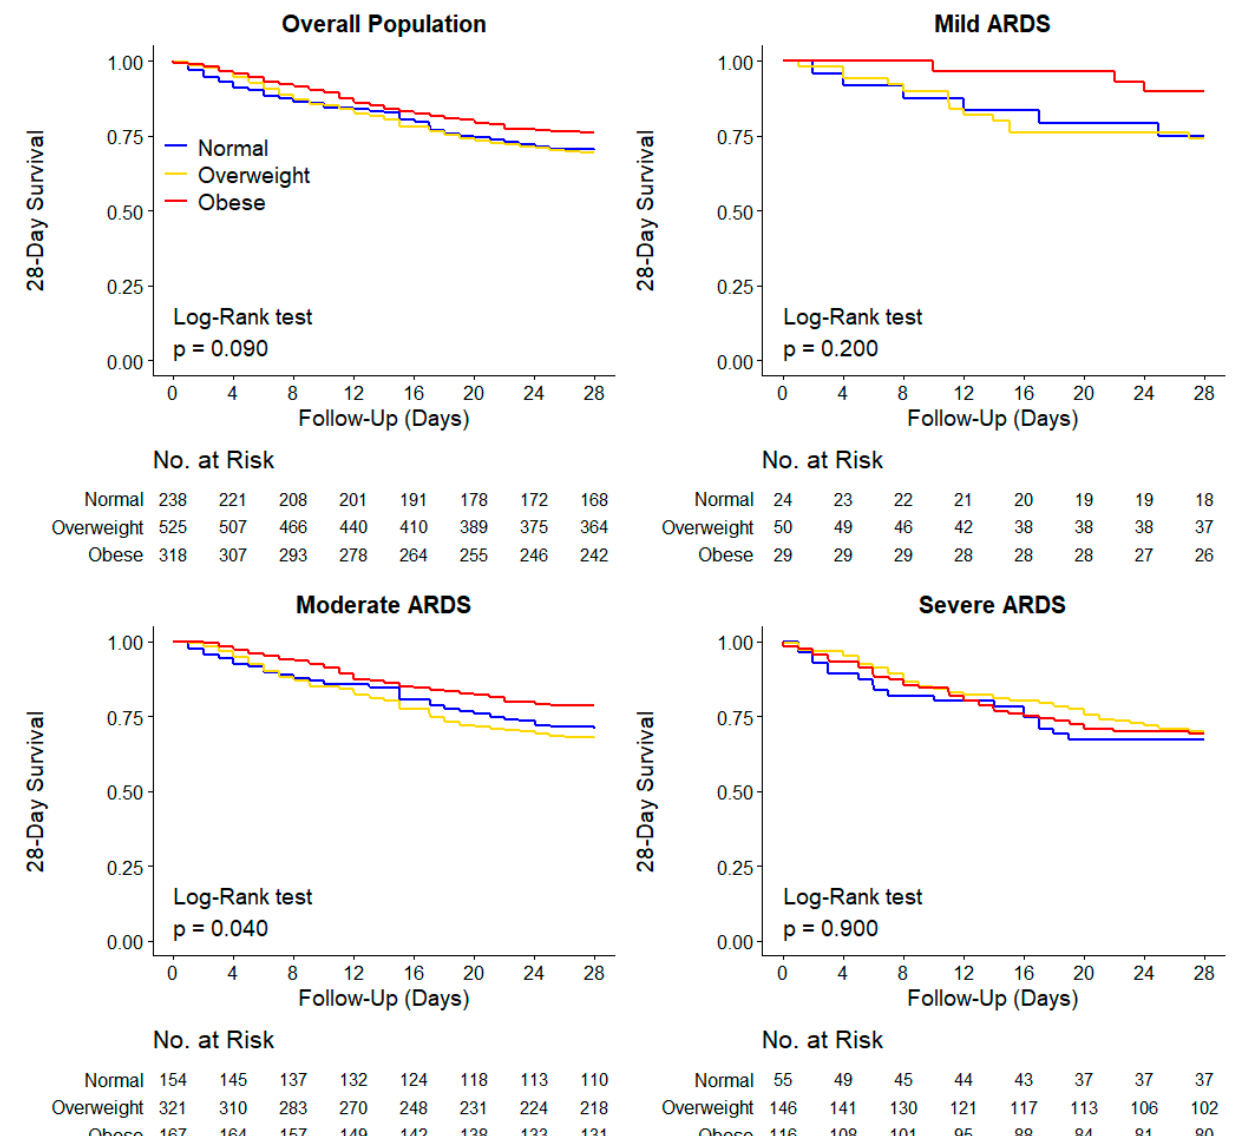
Figure 3. Kaplan–Meier Curves for 28-day mortality in the overall population and groups according to ARDS severity. p values calculated from Log-rank test. Unadjusted and adjusted (shared-frailty) Cox proportional hazard models are shown in Tables S2–S4.